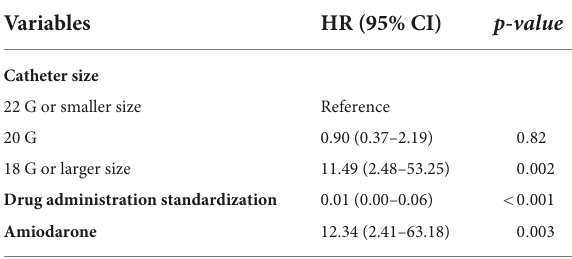
TABLE 4 Marginal Cox regression analysis for phlebitis in the underweight group.